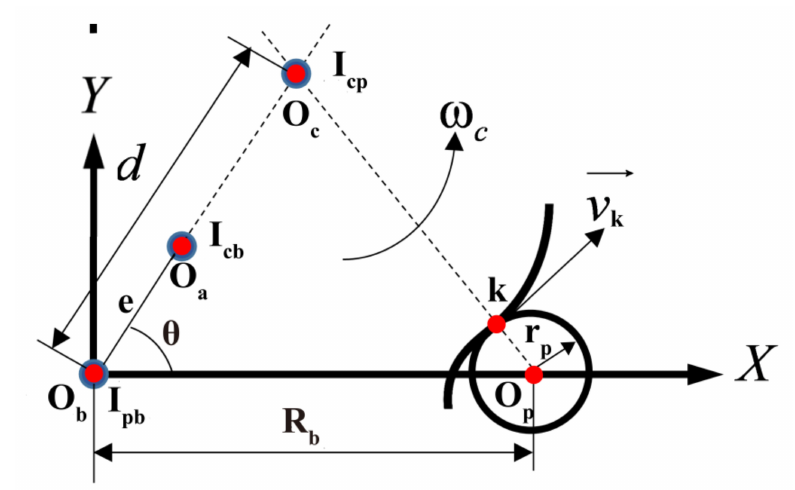
Figure 6. Cycloid and pin tooth contact point (point k) velocity